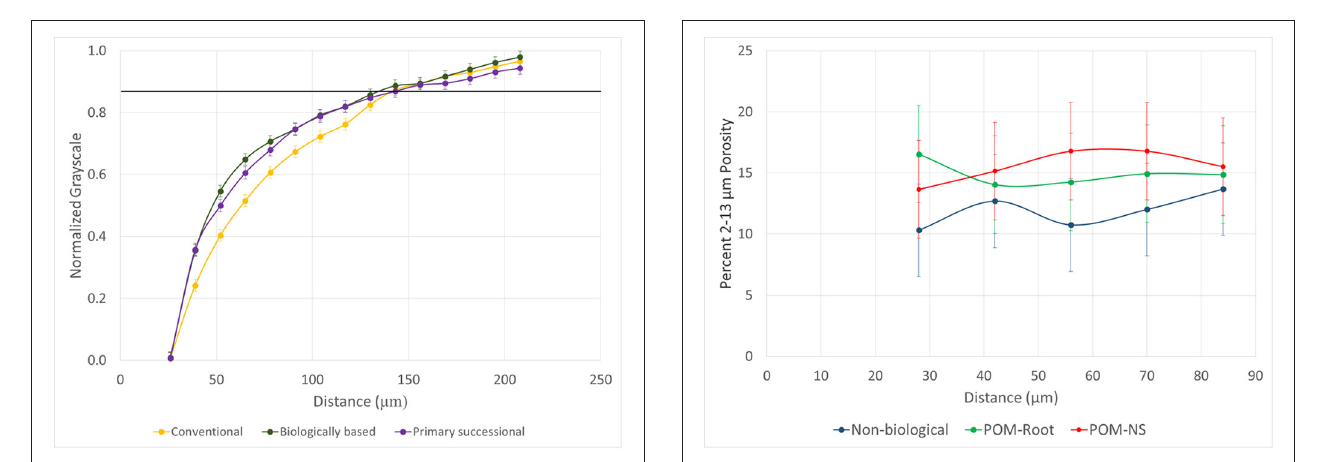
FIGURE 8 | Normalized grayscale values as a function of distance from POM-NS pores for the three management practices ( n = 96). Error bars represent standard errors. The solid black line represents the background grayscale value, i.e., the average grayscale value of the entire aggregate.